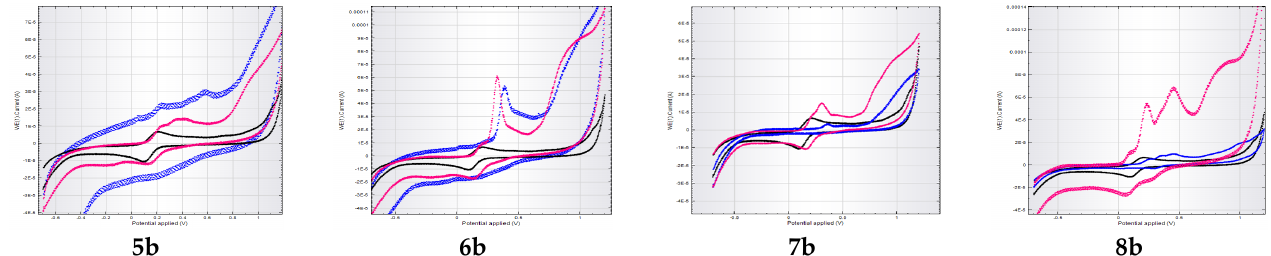
Figure A1. Overlapped CVs for 0.5 mM potassium ferricyanide (black); 0.5 mM solution of the novel synthesized compounds (blue) and of solutions with equal concentrations of 0.5 M of ferricyanide and one compound at a time (pink) prepared in 0.1 M HClO 4 on graphite SPE.